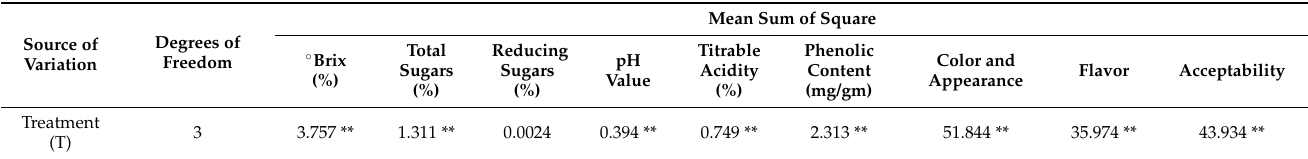
Table 1. Two-way ANOVA showing the effect of steam treatment on thephysico-chemical properties and sensory evaluation atdifferent storage intervals of sugarcane